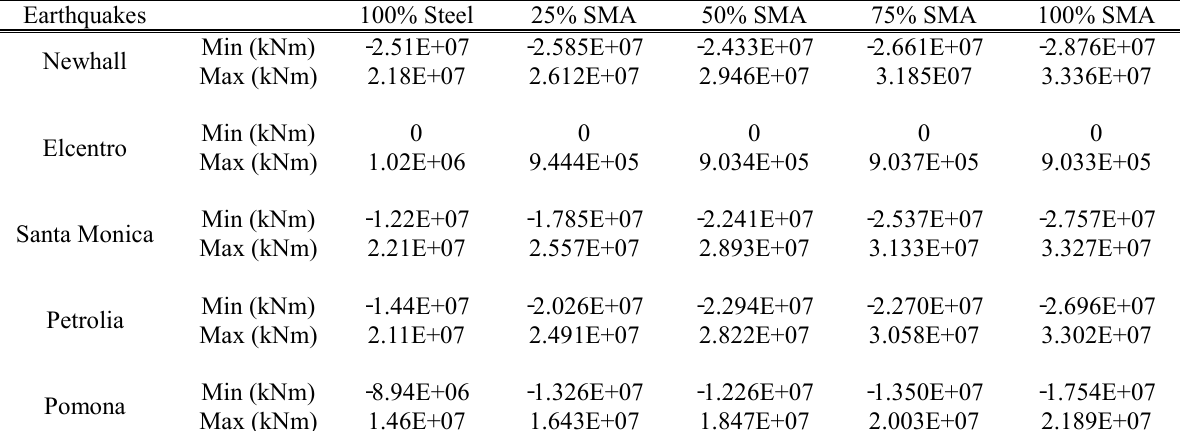
Minimum and Maximum Base Moments for Newhall Earthquake Earthquakes